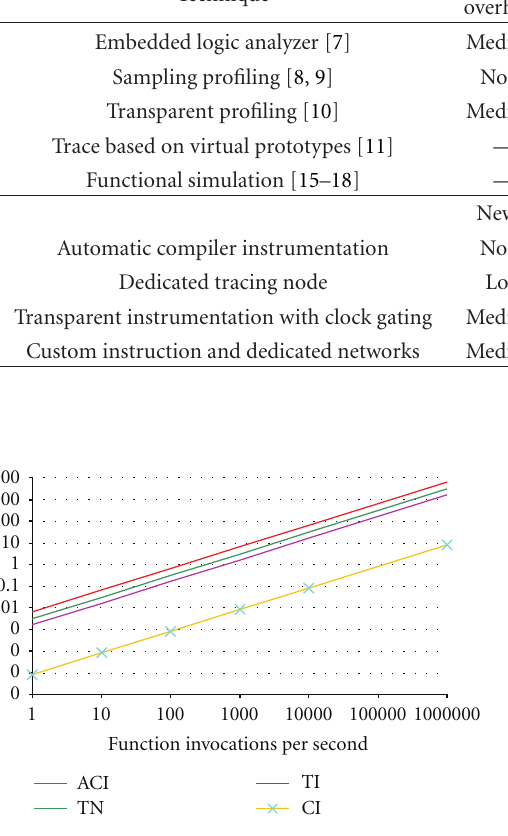
Figure 17: Instrumentation overhead as a function of function invocations per second for the di ff erent proposed